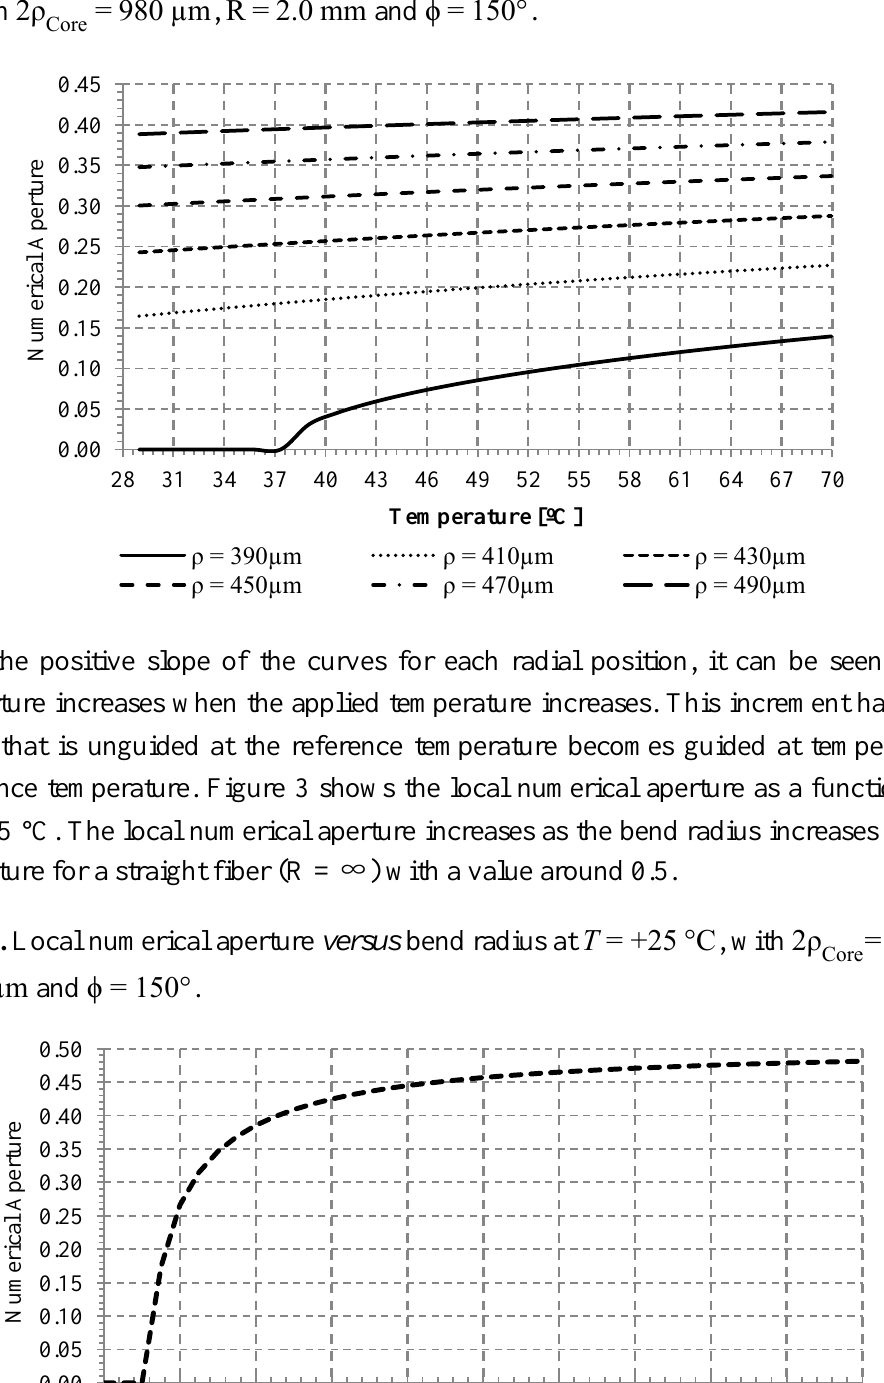
Figure 2. Local numerical aperture versus temperature for several radial positions in the core, with ρ m, mm and . ore